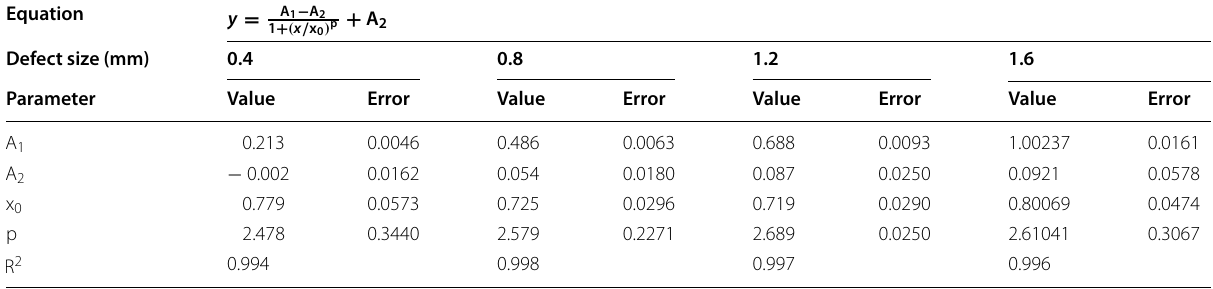
Table 3 Coefficients and correlation coefficients of fitting curves in Figure 10(a)